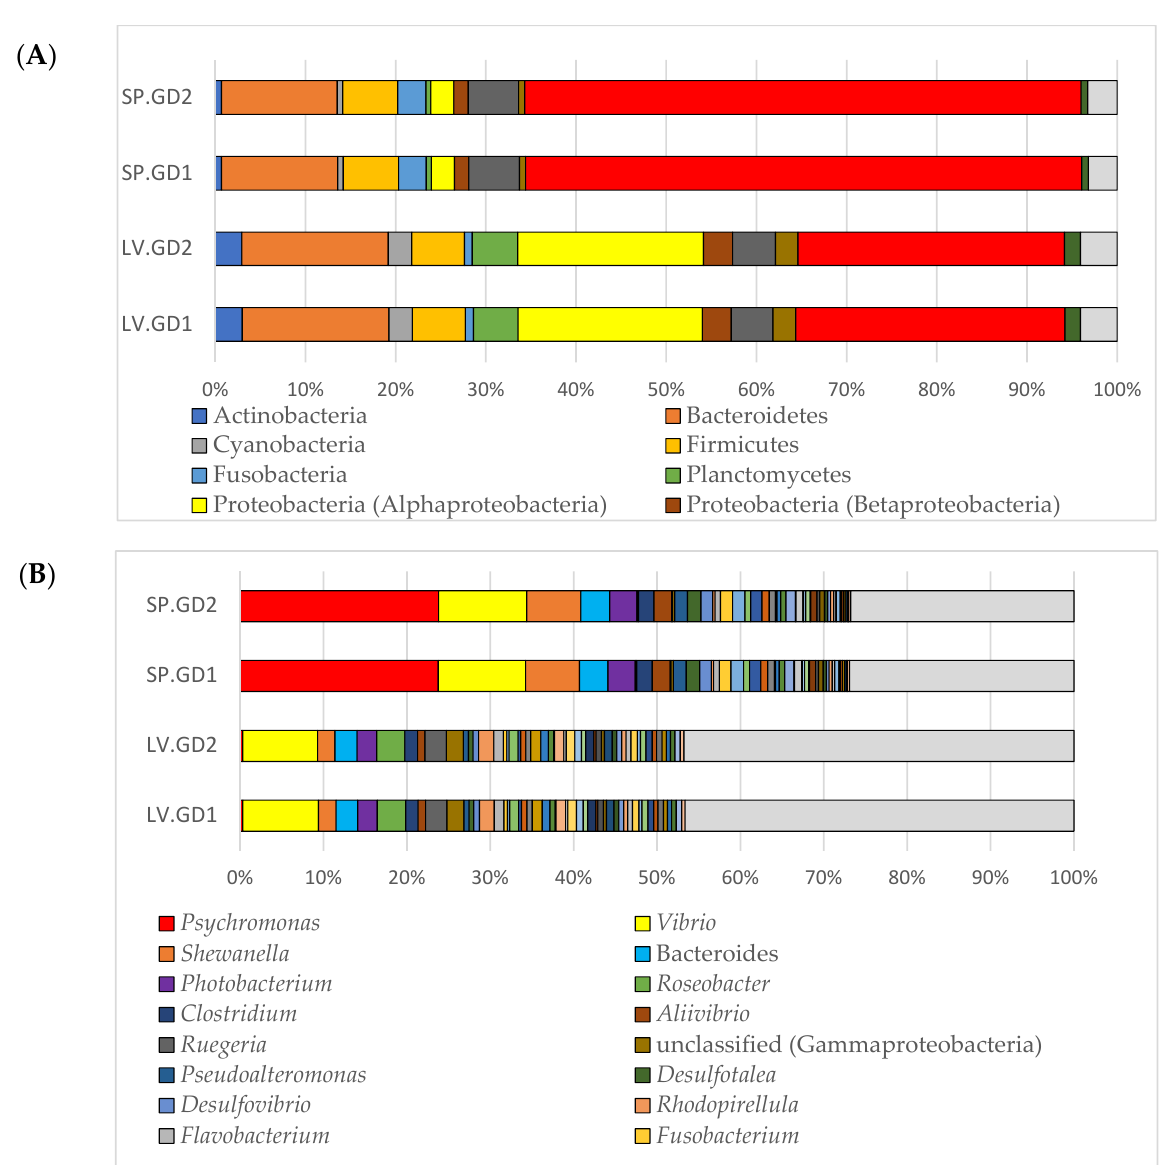
Figure 1. Relative abundance stacked column bar graphs illustrating the taxa distribution assigned to domain Bacteria through RefSeq as implemented in MG-RAST (v4.0.3). ( A ) The phylum level (class for Proteobacteria) distribution is shown, and phyla with an average abundance of <1% were listed as “Other”. ( B ) The relative abundance of the top 50 genera across all samples was plotted. The low represented taxa were categorized as “Other”. Bar graphs generated using Microsoft Excel software (Microsoft, Seattle, WA, USA), and samples are indicated as follows: LV.GD = green sea urchin Lytechinus variegatus gut digesta ; SP.GD = purple sea urchin Strongylocentrotus purpuratus gut digesta.